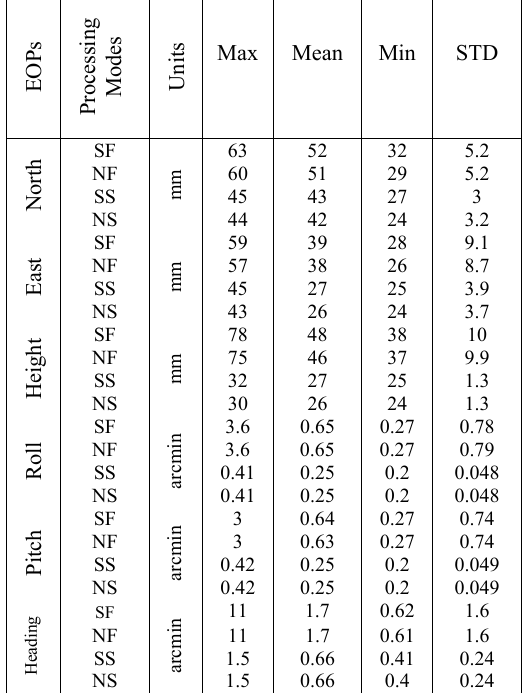
Table 1. Statistical information of EOPs uncertainties in Single-Forward (SF), Network-Forward (NF), Single-Smooth (SS), and Network-Smooth (NS) processing methods.